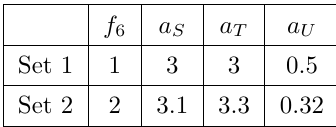
Table 1 . The two sets of parameters that we investigated in detail. For both of them we (cid:12)nd a stable anti-de Sitter vacuum with positive masses. m 2 1